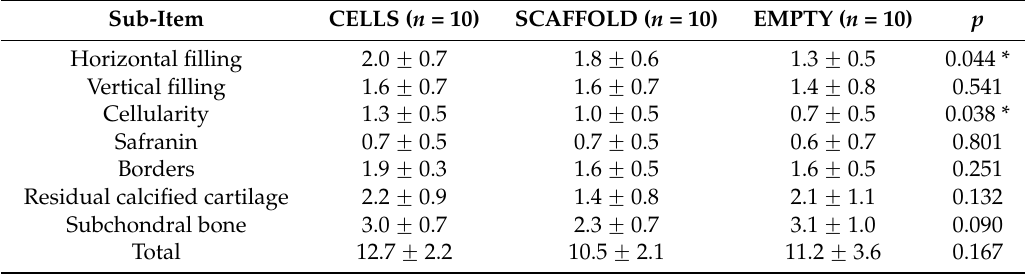
Table 2. The Partial Thickness Model scale results, expressed as mean ˘